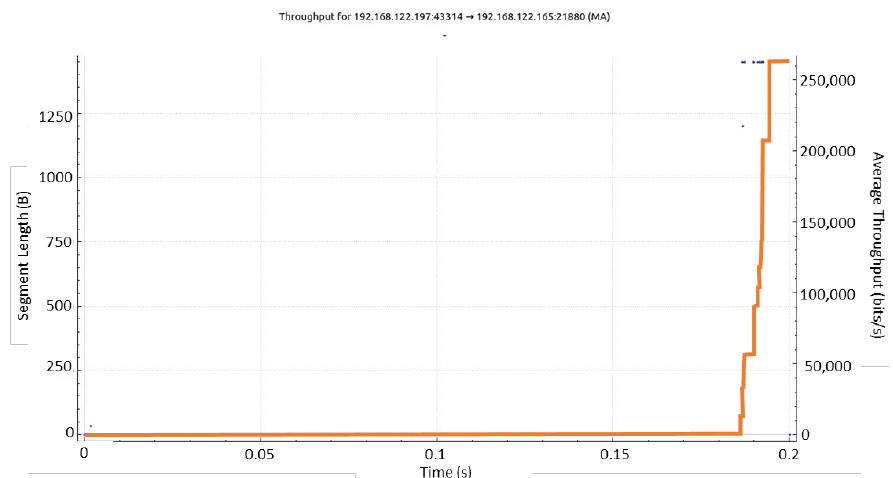
Figure 8. Non-encrypted file throughput.